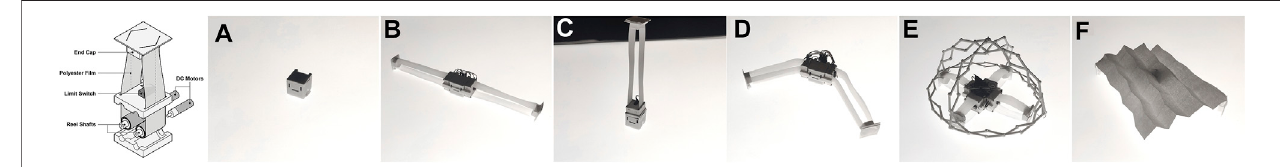
Frontiers in Robotics and AI |